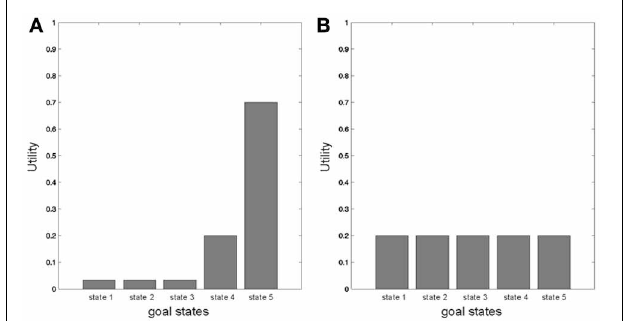
FIGURE 1 | Illustrating two different contexts in which a valuable policy is defined according to the likelihood of visiting a goal state with highest utility (A–because one goal state is clearly favored by the agent) or according to the likelihood of visiting many different states (B–because no goal state is favored), depending on the different representations of utilities of goal states in an agent’s prior beliefs.